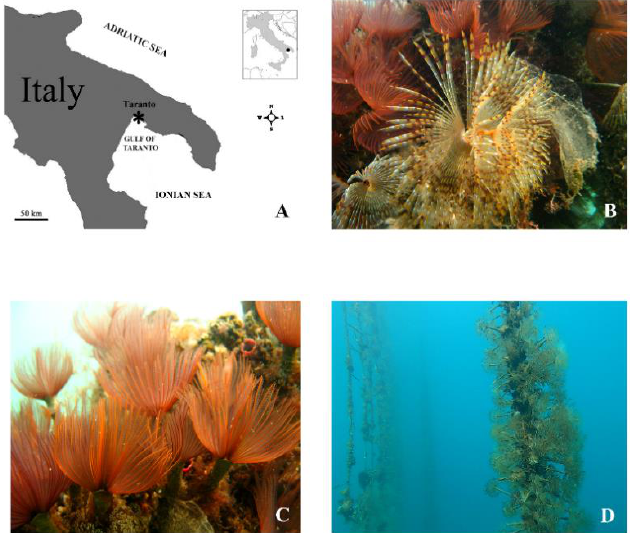
Figure 1. ( A ) Map of the sampling site in the Gulf of Taranto (Mediterranean Sea, Ionian Sea, Italy). ( B ) Specimen of the polychaete Sabella spallanzanii . ( C ) Specimens of the polychaete Branchiomma luctuosum . ( D ) Rearing trials of the polychaetes in the integrated multitrophic aquaculture (IMTA) system realized in the Gulf of Taranto. Polychaetes were arranged in polypropylene nets, which were hung vertically within a typical long-line system.